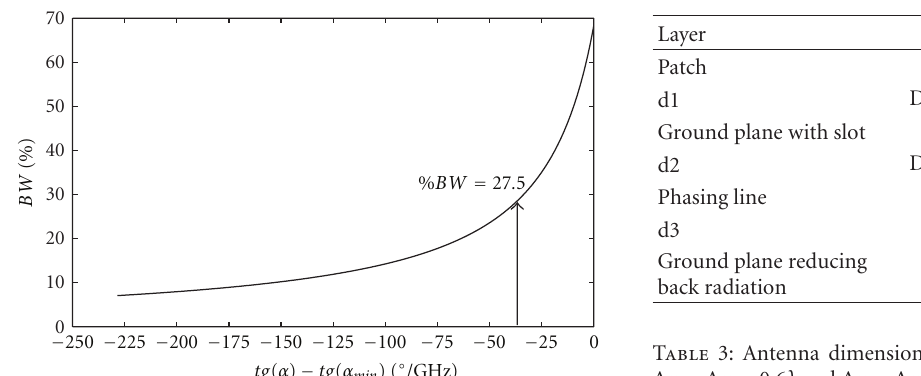
Figure 17: Comparison among the normalized gain patterns (broadside direction). Table 2: Element stratification (reflectarray prototypes presented in [6, 7]).